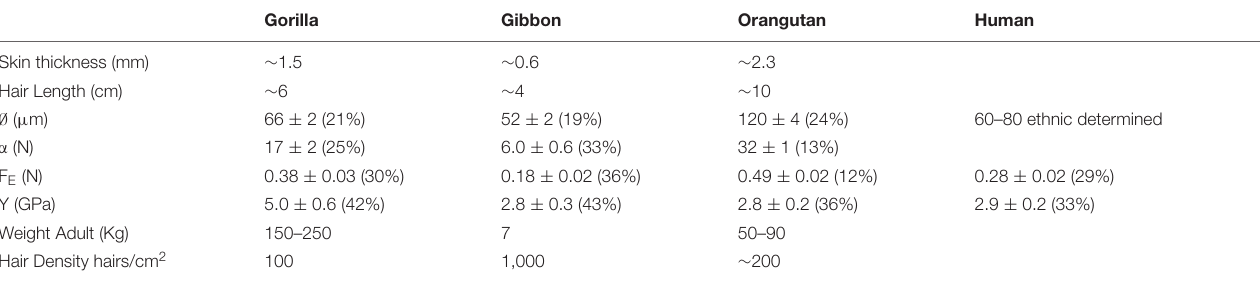
TABLE 1 | Thickness of the skin and length of hair (estimated) average values of the measured values of the hair diameter ∅ , of the linear regression coefficient α , of the elastic limit F E , and from Young modulus